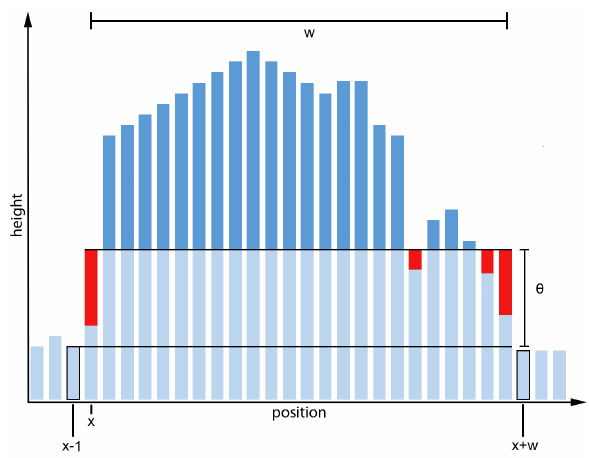
Table 1. Pseudo-Code for finding the best set of (x, w) for one row of DSM